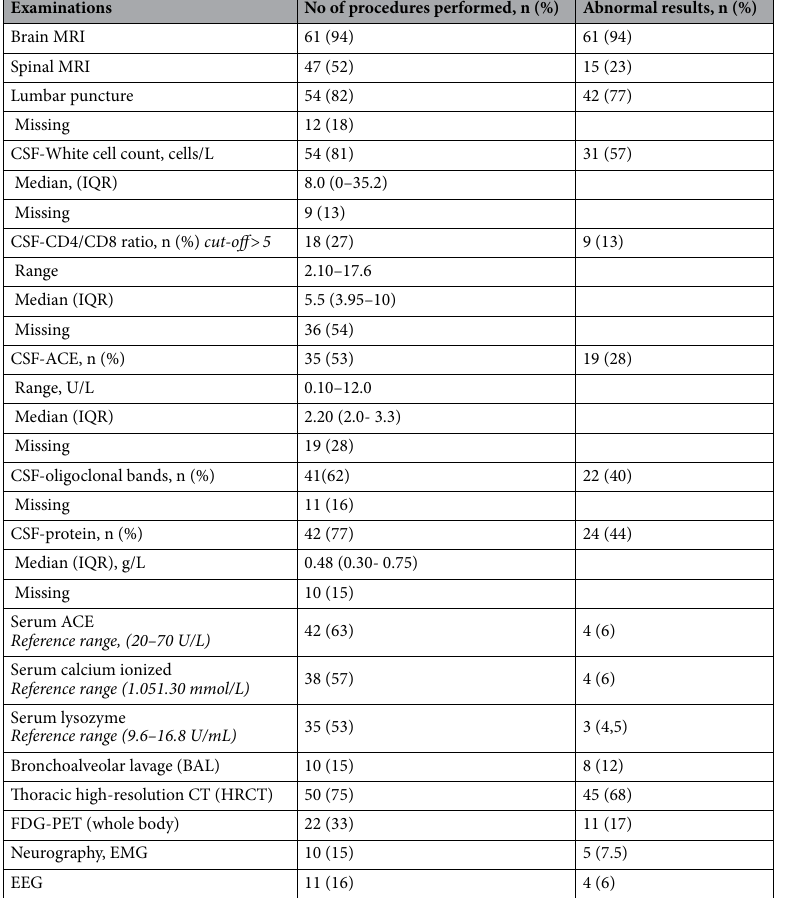
Table 3. Diagnostic work-up of patients with neurosarcoidosis (n =